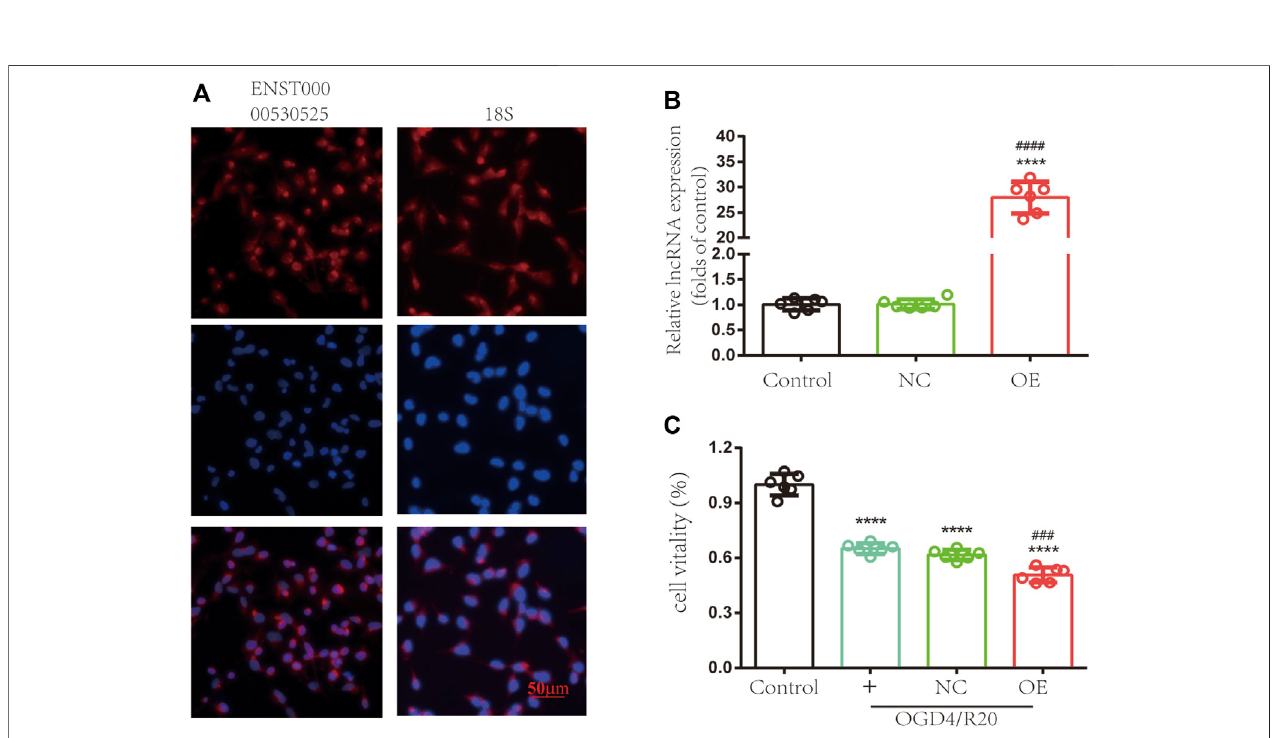
FIGURE 6 | Upregulating the expression of lncRNA ENST00000530525 affects the vitality of hCMEC/D3 cells. (A) FISH showed that ENST00000530525 was mainly distributed in the cytoplasm, similar to the control group 18S. Scale bar: 50 μ m. (B) The transduction ef fi ciency detected by RT – qPCR. (C) The CCK-8 assay revealed cell vitality. NC: negative control; OE: over expression; OGD4/R20: 4 h of OGD and 20 h of reoxygenation. **** p < 0.0001 (vs. control); ### p < 0.001, #### p < 0.0001 (vs. NC), n = 6, one-way ANOVA.